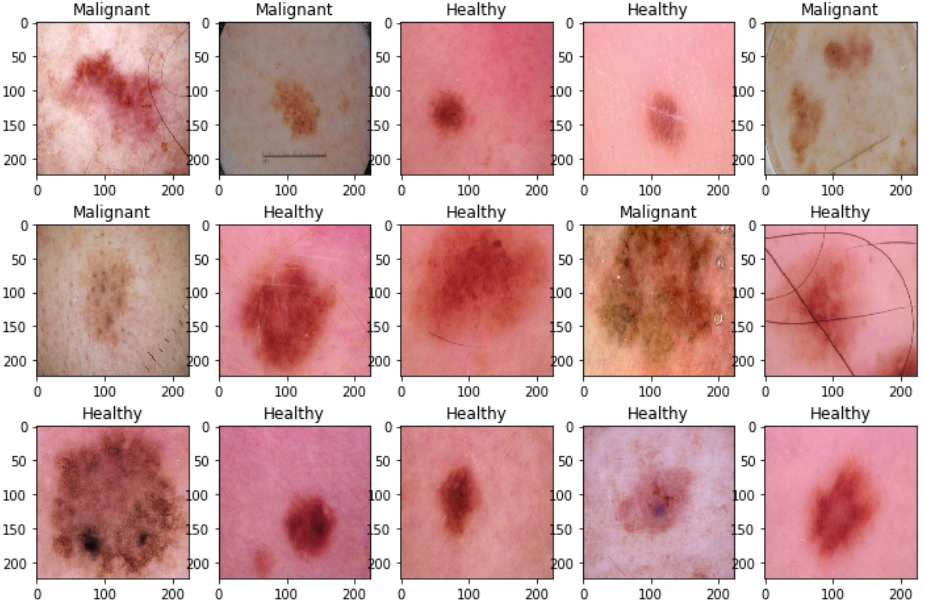
Figure 3. Skin image samples of healthy and malignant from skin disease